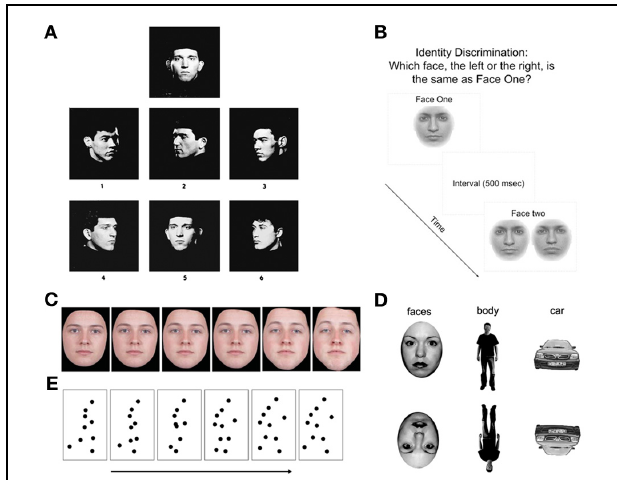
FIGURE 1 | (A) Plate from the Benton Facial Recognition Test (Benton, 1983). Participants indicate which of the six images match the target. (Published in Busigny and Rossion, 2010, p. 969). (B) Identity matching task used by Norton et al. (2009). (C) Example of morphed images ranging from “no sex” (50% male, 50% female) to 100% male face (from Bediou et al., 2005, , p. 528). (D) Examples of upright and inverted stimuli used in Soria Bauser et al. (2012). (E) Example of semi-successive frames of the point-light displays (walking) used in Kim et al. (2005).